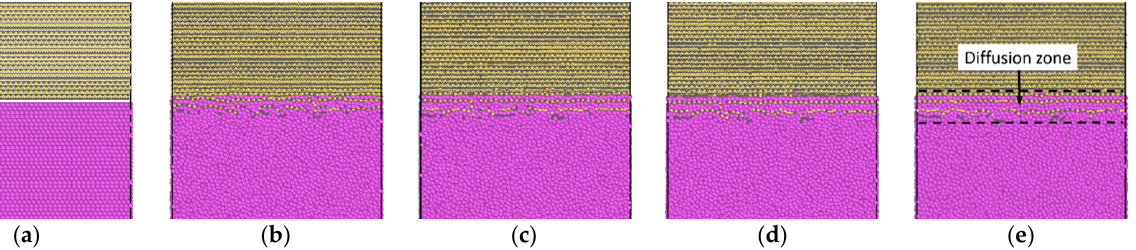
Figure 2. Cross-sectional views of the atomic configurations of C-terminated 6H–SiC/Al interface. ( a ) Atomic structure at 300 K before relaxation and the configuration after maintaining the system at 2000 K for ( b ) 0 ns, ( c ) 2 ns, ( d ) 4 ns, and ( e ) 6 ns.